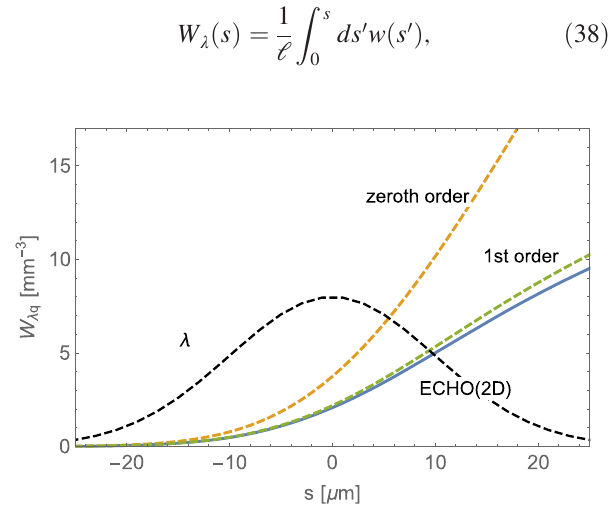
FIG. 13. Vertical quad bunch wake for a Gaussian beam with σ ¼ 10 μ m offset in the RadiaBeam/LCLS dechirper. The offset z is y ¼ 0 . 5 mm and the half-aperture is the nominal a ¼ 0 . 7 mm. Given are the numerical results of ECHO(2D) (blue), and the analytical zeroth order (red) and 1st order results (green). The bunch shape λ ð s Þ with the head to the left is shown in